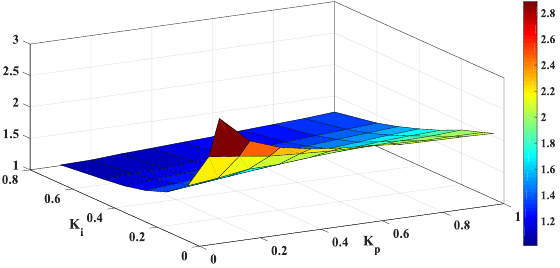
Figure 8. Maximum permitted delay for an EV aggregator with α 1 = 0.4 and τ M